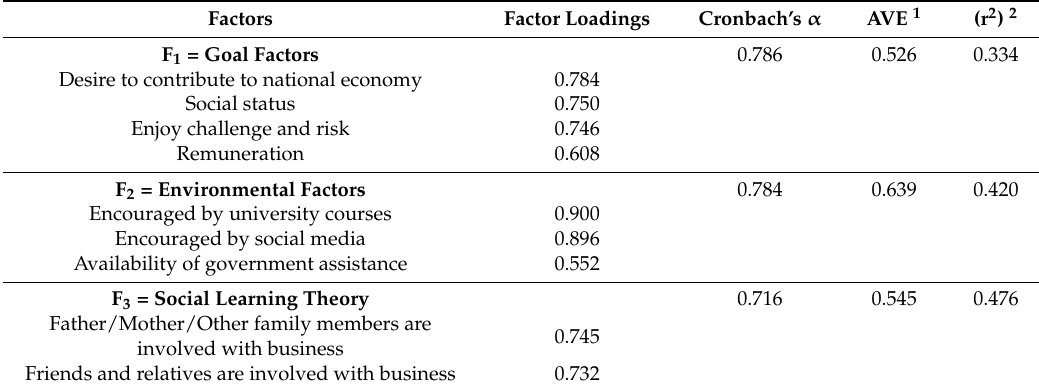
Table 2. Rotated factor matrix, reliability, and validity